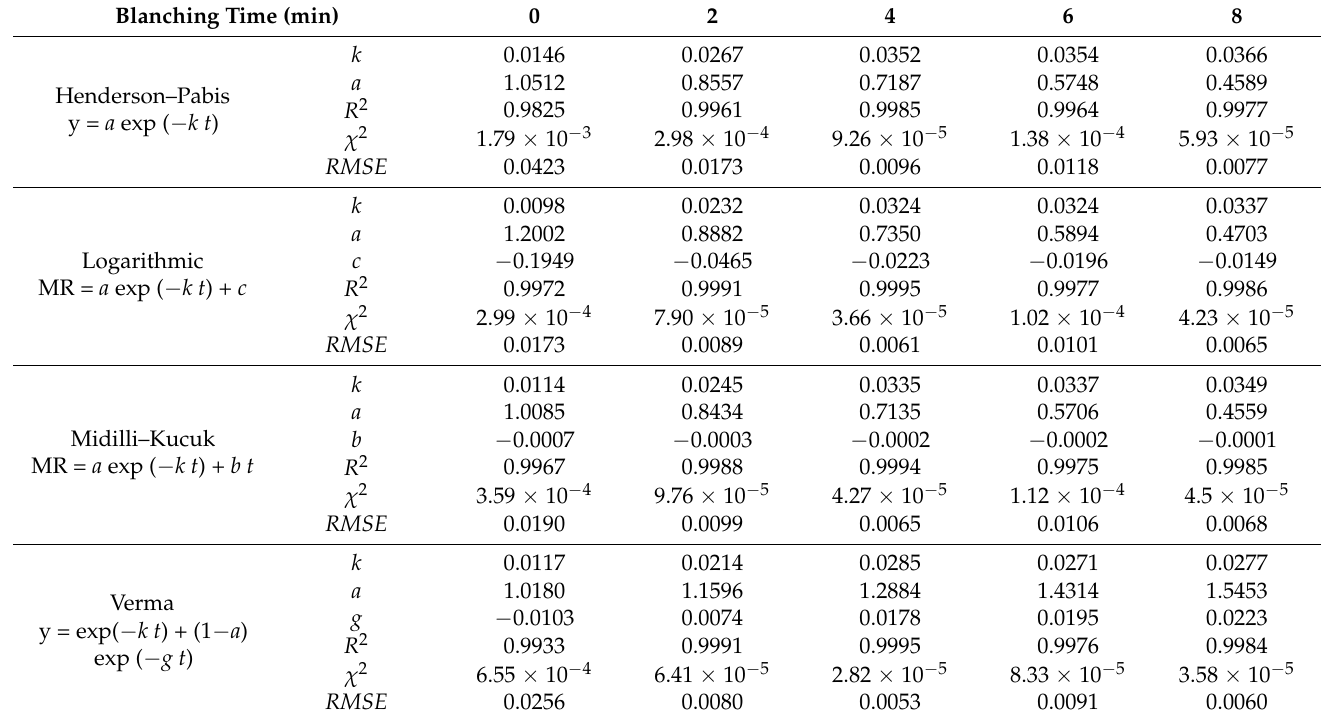
Table 1. Parameters and fitting performance of different drying